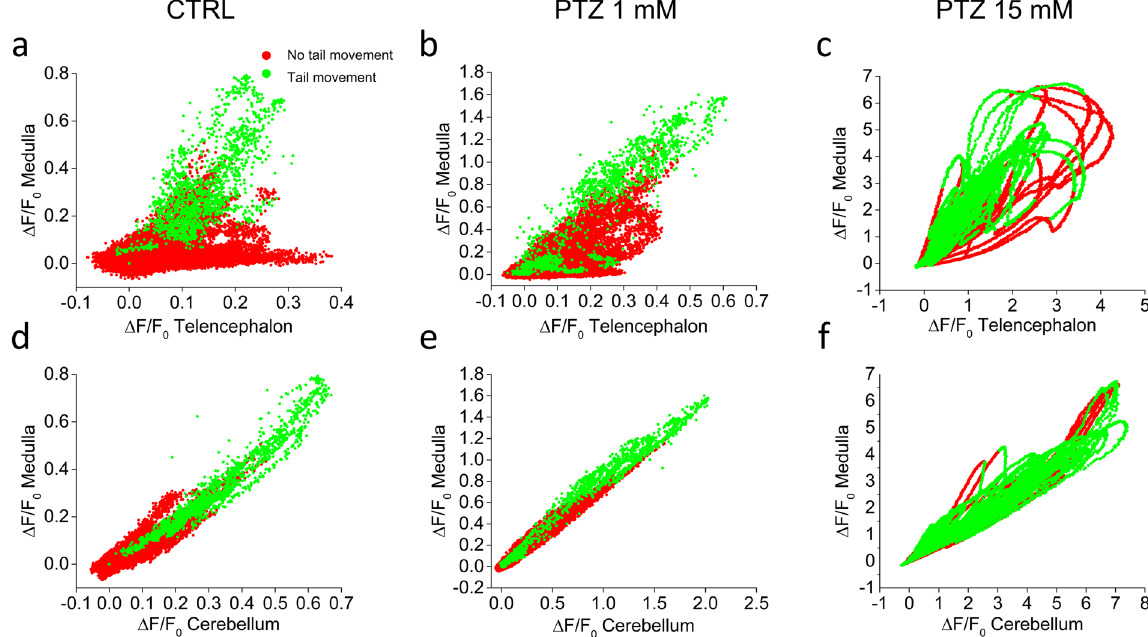
Figure 5. Correlations of brain activity in different regions with locomotor activity. Correlation plots of Δ F/F 0 for chosen pairs of brain regions in control, 1 and 15 mM PTZ. Correlations are shown between telencephalon and medulla (panels a-c) and between cerebellum and medulla (panels d-f). Red and green symbols represent fluorescence data corresponding to resting and swimming times, respectively (see Methods). In panels a and b it is evident the presence of a subset of data characterized by telencephalon activity not associated with medulla activity (panel a) or associated with only low levels of medulla activity (panel b); all those data points correspond to time intervals in which no tail movement takes place. Measurements shown are from the recording performed on one